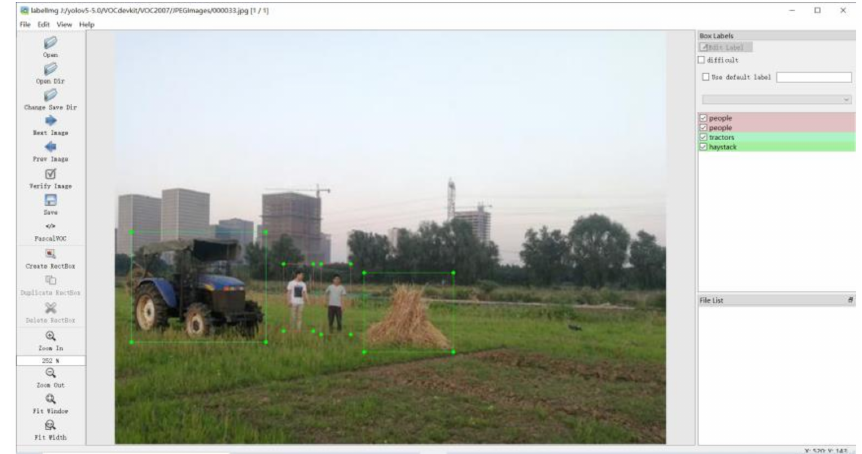
Figure 1. Labeling using LabelImg.